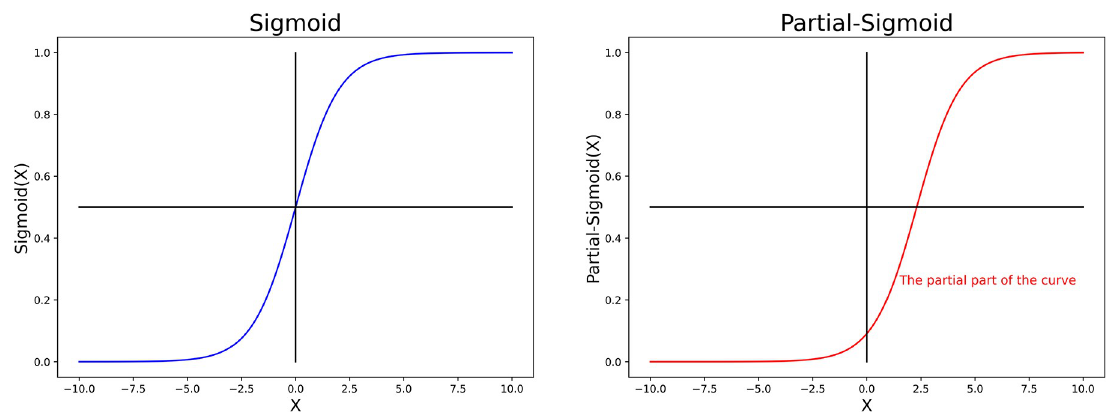
Fig 1. Sigmoid function and partial-sigmoid function.